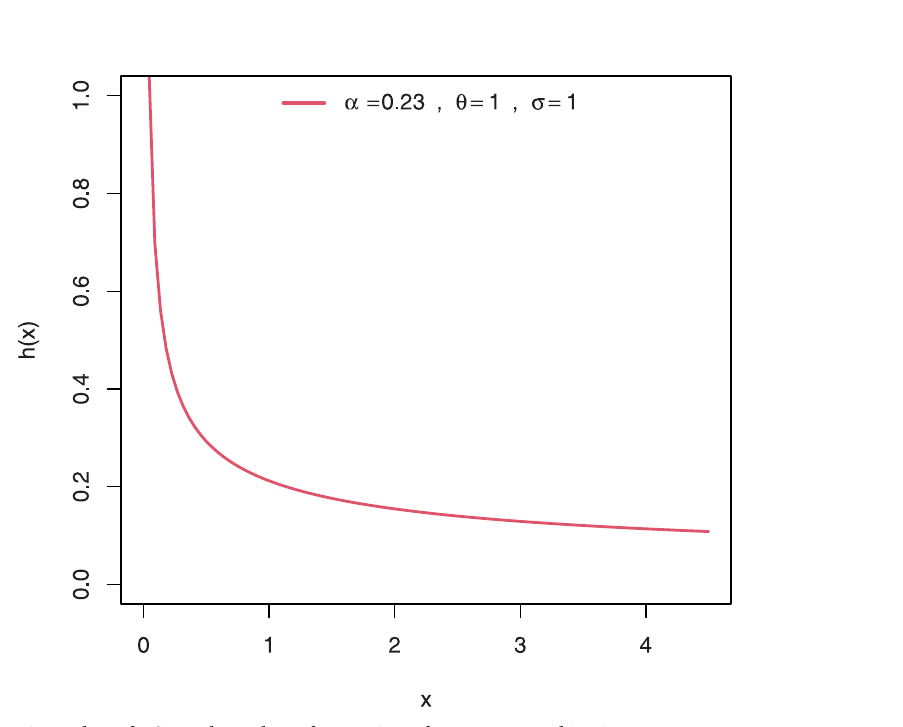
Fig 6. Plots of EGuNH hazard rate for a variety of parameter combinations.